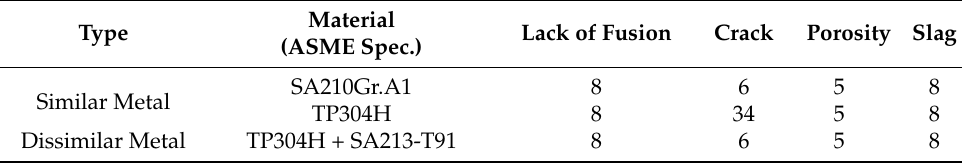
Table 2. Flaw quantities of the tube weld specimens.